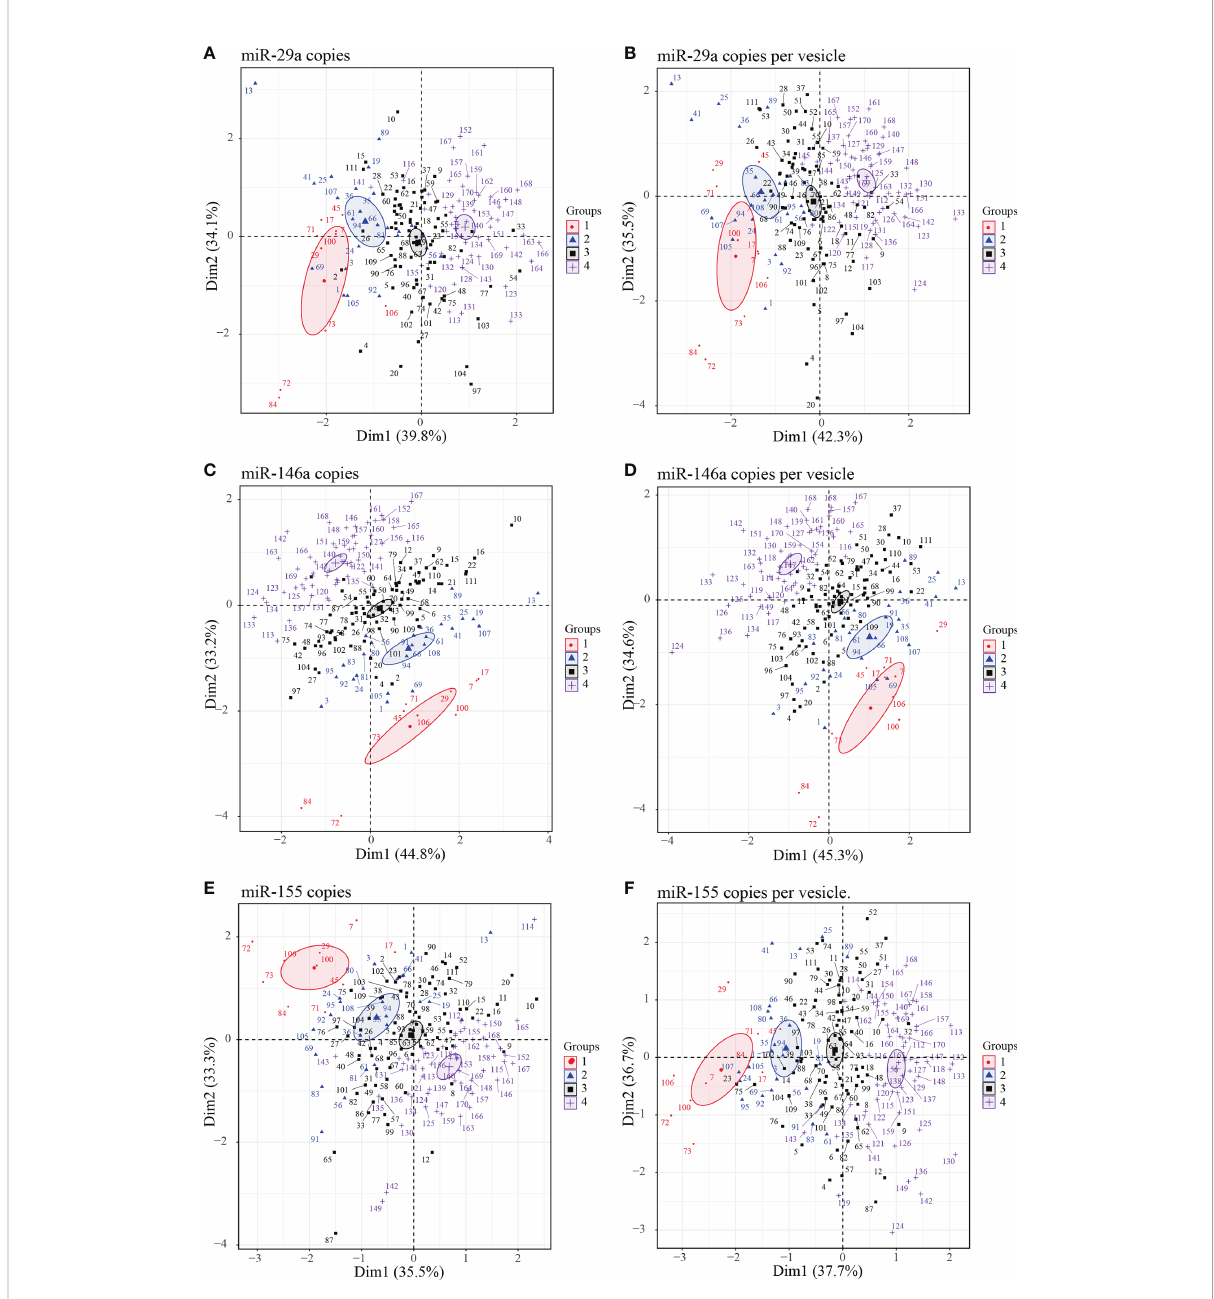
FIGURE 6 Principal component analysis (PCA) plots of individuals large and small EVs microRNA content. Graphs of individual large and small EVs miR-29a (A, B) , miR-146a (C, D) and miR-155 (E, F) content respectively expressed as copies per µg of RNA and copies per vesicle were performed in PCA for HIV negative and HIV+ ART-treated participants with undetectable viral load participants divided into four groups. Group 1 (participants with CD8 T cell < 500 cells/µL, CD4 T cell ≥ 500 cells/µL, and ratio CD4/CD8 ≥ 1); group 2 (participants with ratio CD4/CD8 ≥ 1 and CD8 T cell ≥ 500 cells/µL), group 3 (participants with CD4/CD8 < 1 and CD8 T cell ≥ 500 cells/µL), and group 4 (HIV negative independently to CD4 or CD8 T cells count and ratio CD4/CD8). Ellipses were drawn around the centroids of the clusters, representing 95% con fi dence